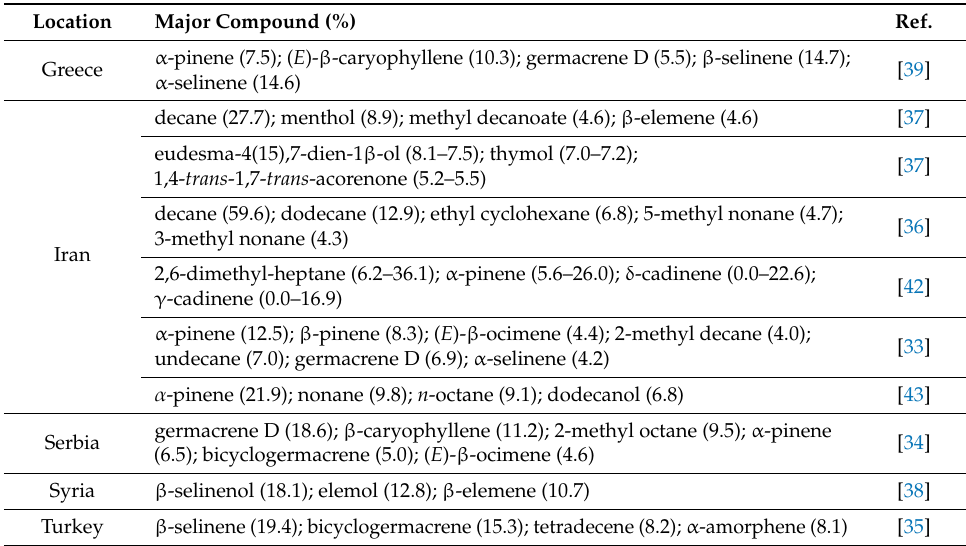
Table 1. Review of the major volatile constituents of H. perforatum essential oils